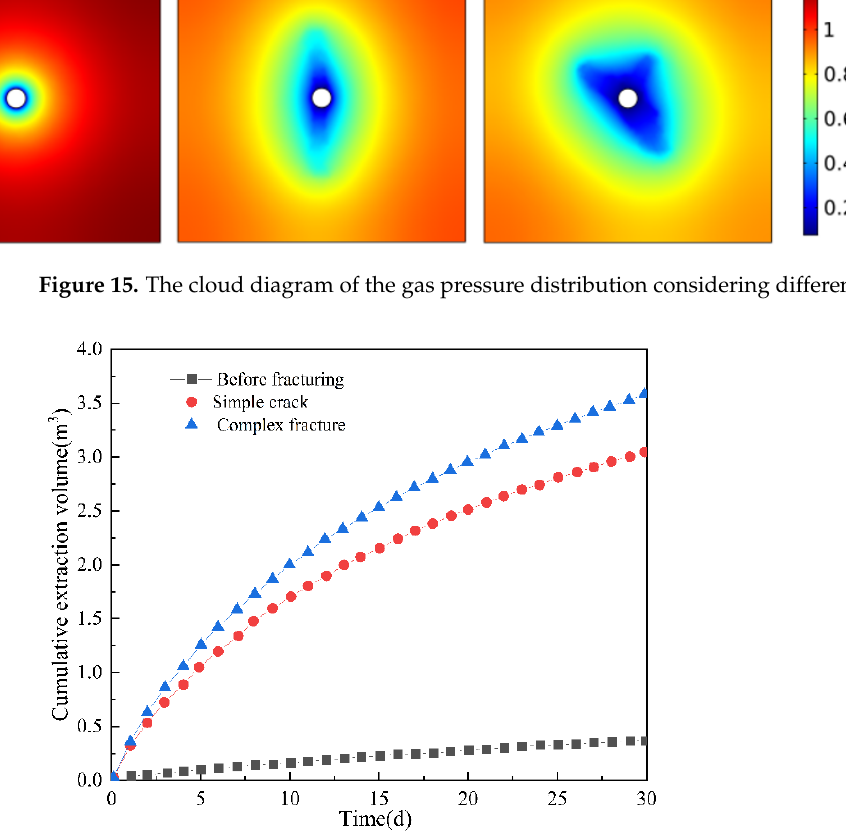
Figure 16. The change curve of cumulative gas extraction volume with time.